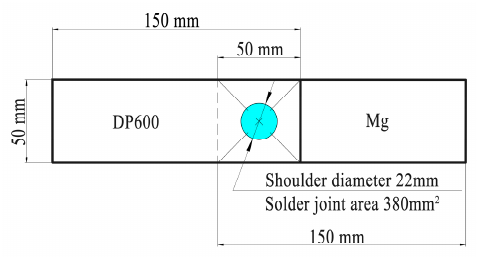
Figure 2. The lap joint diagram of friction stir keyholeless spot welding (FSKSW).